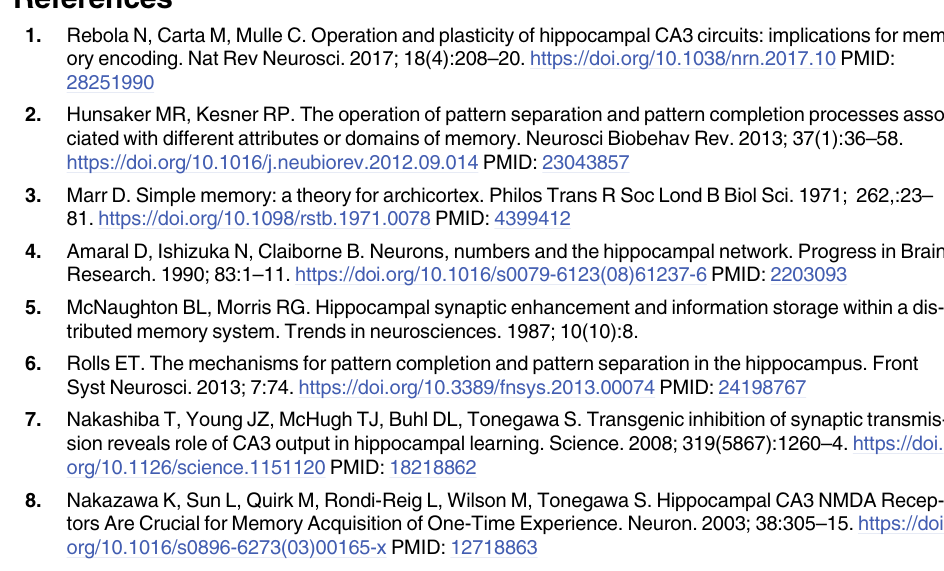
S2 Table. Detailed kinetics of normalized Arc/H1a ensemble size in EC layer II and CA3 as lapse of